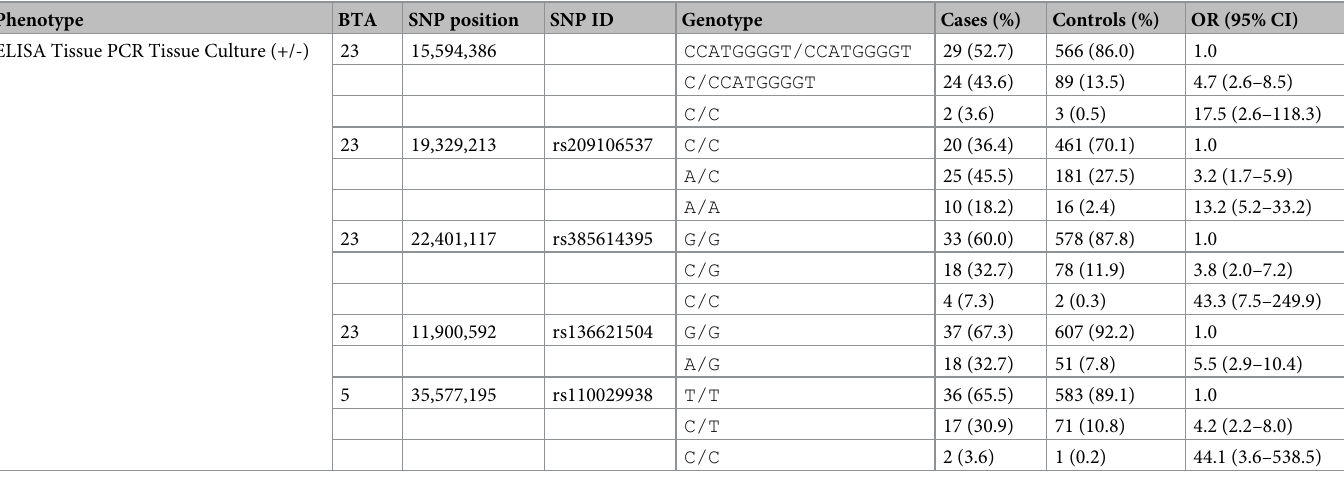
Table 4. Odds ratio (OR) for some the SNPs associated with a positive ELISA-tissue PCR-tissue culture diagnosis (+/-)(P < 5 x 10 − 7